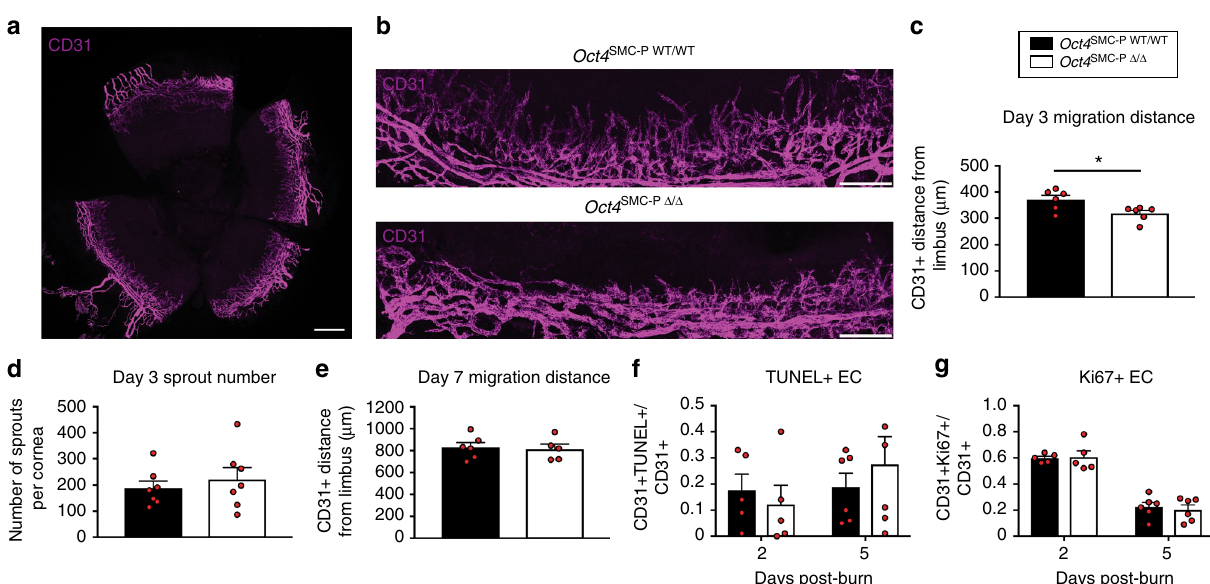
Fig. 5 SMC-P Oct4 knockout resulted in delayed migration of CD31 + EC following corneal burn. a Whole mount immunostaining of a representative Oct4 SMC-PWT/WT cornea for CD31 (magenta) at day 3 post-corneal burn. Scale bar = 500 μ m. b Fields of view from Oct4 SMC-PWT/WT and Oct4 SMC-P Δ / Δ mice stained with CD31 at day 3 post-corneal burn. Scale bar = 200 μ m. c Quanti fi cation of the average distance of CD31 + EC away from the A – V pair of the corneal limbus at day 3 post-burn. d Quanti fi cation of EC sprout number throughout the cornea. e Quanti fi cation of the average distance of CD31 + EC away from the A – V pair of the corneal limbus at day 7 post-burn (( c – e ) n = 6 WT, 6 KO). f Quanti fi cation of the number of TUNEL + EC in cornea at day 2 ( n = 5 WT, 5 KO) and day 5 ( n = 6 WT, KO) post-burn. g Quanti fi cation of the number of Ki67 + EC in cornea at day 2 (n = 5 WT, 5 KO) and day 5 post- burn ( n = 6 WT, 6 KO). Values = mean ± s.e.m. Statistics were performed using unpaired two-tailed t -test ( c – g ). * P <